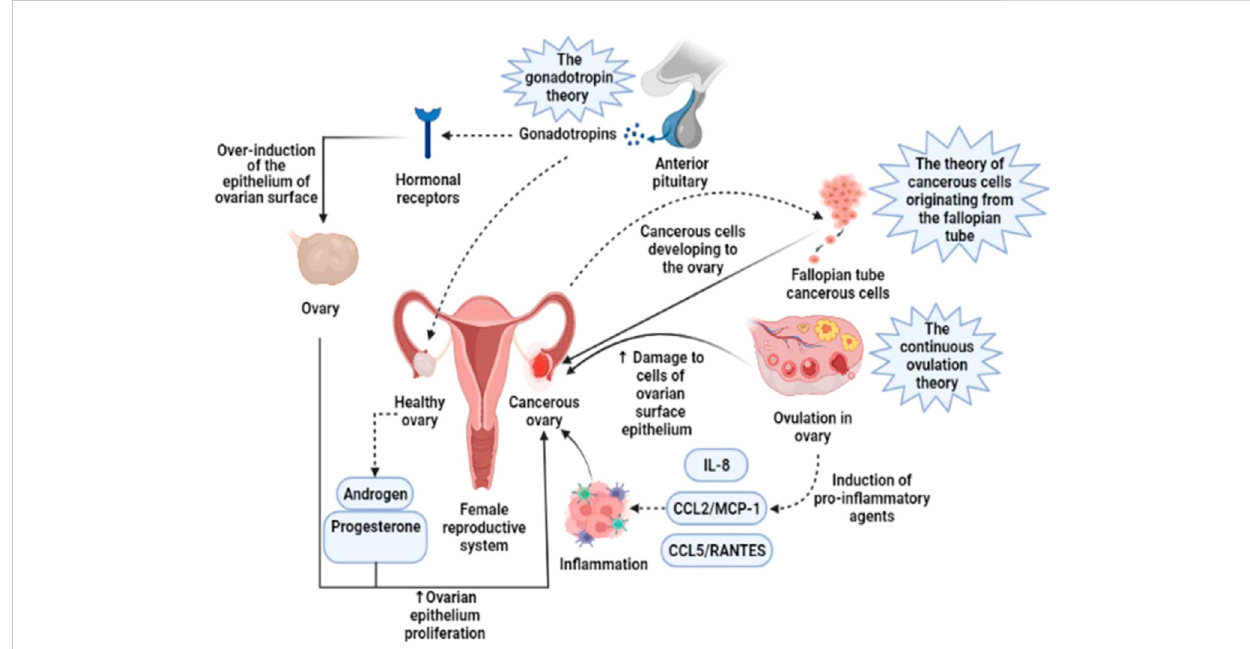
FIGURE 1 Three basic theories concerning the onset of OC are based on the stimulation of the ovarian surface epithelium by hormone receptors, the enhancedproductionofpro-in fl ammatorysubstancesduringcontinuousovulation, andmalignantcellsarisingfromthefallopiantube.IL-8, Interleukin- 8; CCL2/MCP-1, Monocyte chemoattractant protein-1; CCL5/RANTES, CC Chemokine Ligand-5 (Rezaei-Tazangi et al.,